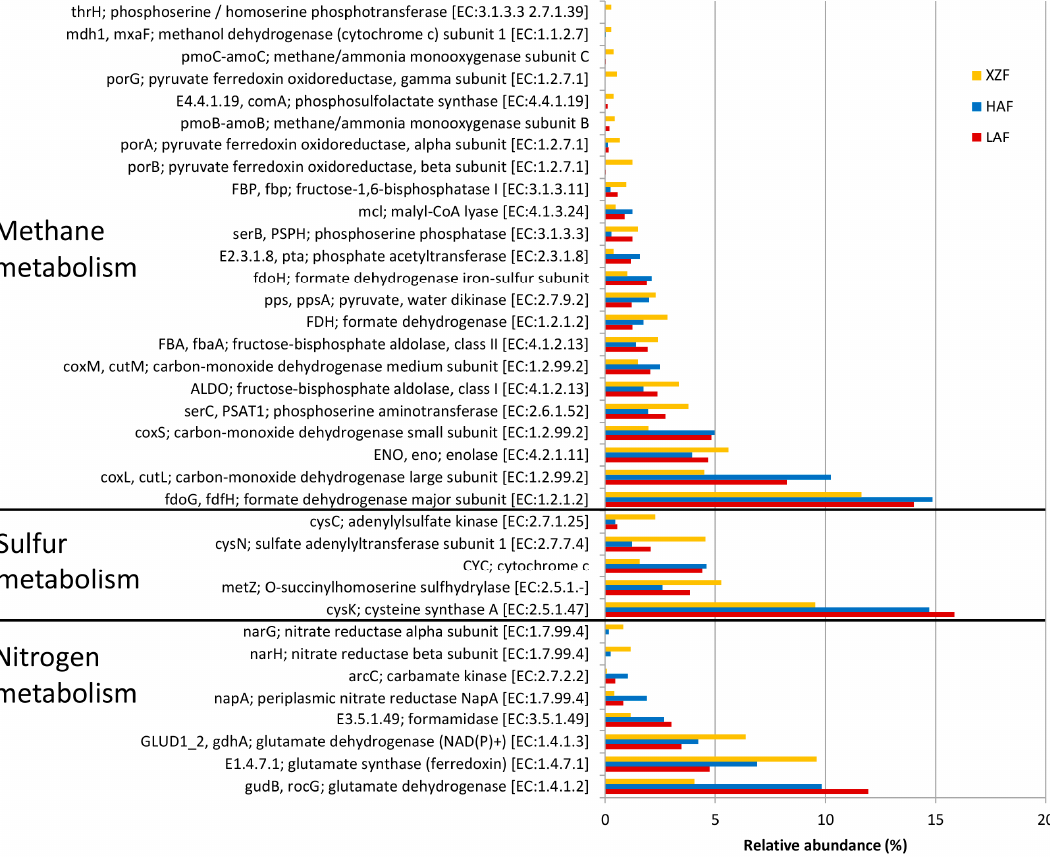
Figure 3. Percentage of genes involved in methane, sulfur and nitrogen metabolism with statistically significant differences ( p < 0.05) between sampled sites.